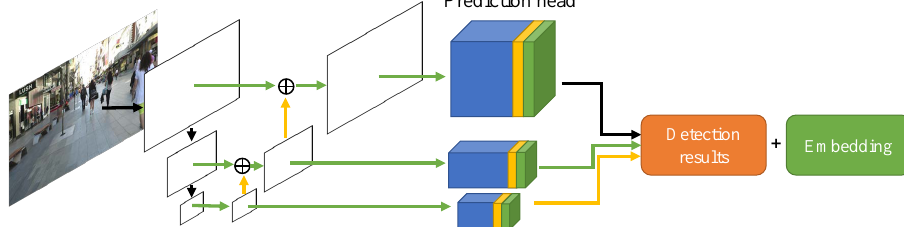
Figure 14. A detection and target association model [70] in MOT15 benchmark [8], which com- pares Separate Detection and Embedding (SDE), two-stage model, and Joint Detection and Embed- ding